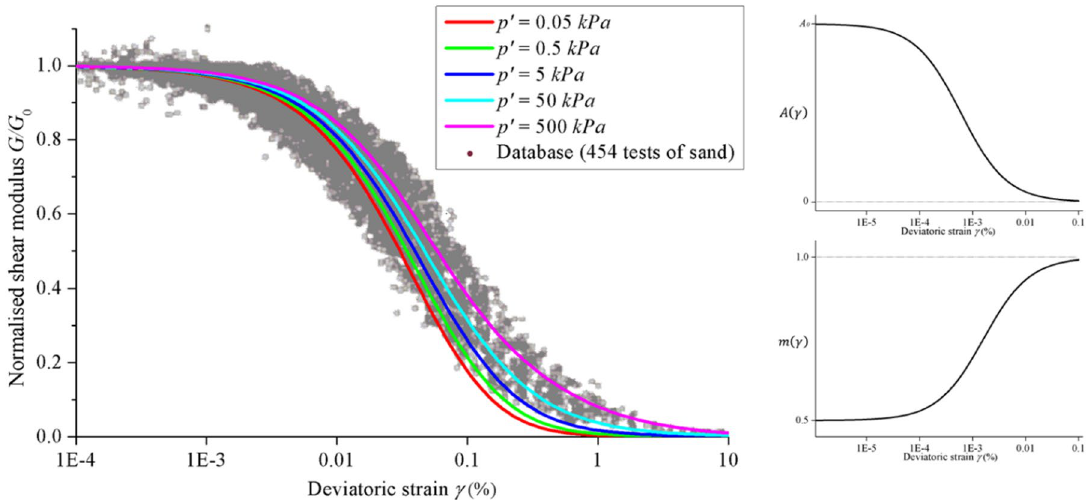
Figure 2. Oztoprak and Bolton’s nonlinear shear modulus plotted together with extensive test data, and model fitting parameters m (γ) and A (γ) 17